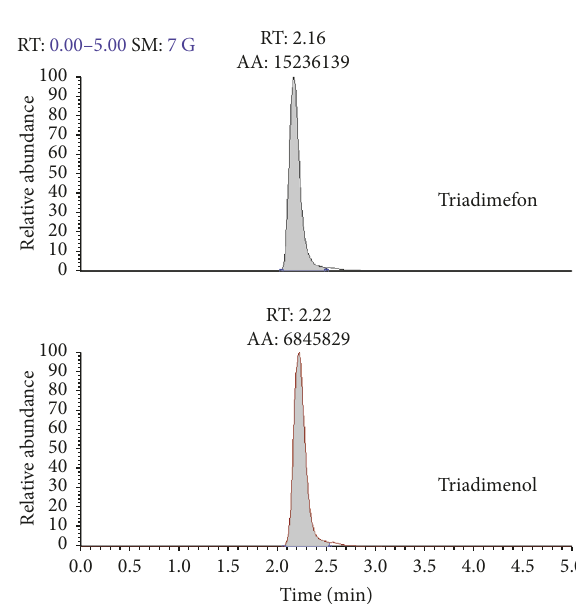
Figure 1: HPLC/ESI-MS/MS chromatograms of triadimefon and triadimenol in the standard